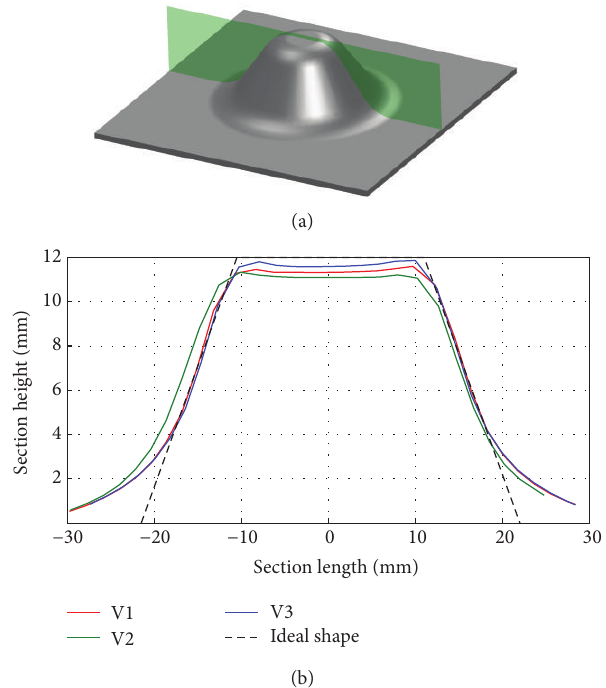
Figure 9: The position of the section plan utilised to measure profiles and comparison of resulting profiles and the ideal shape of the